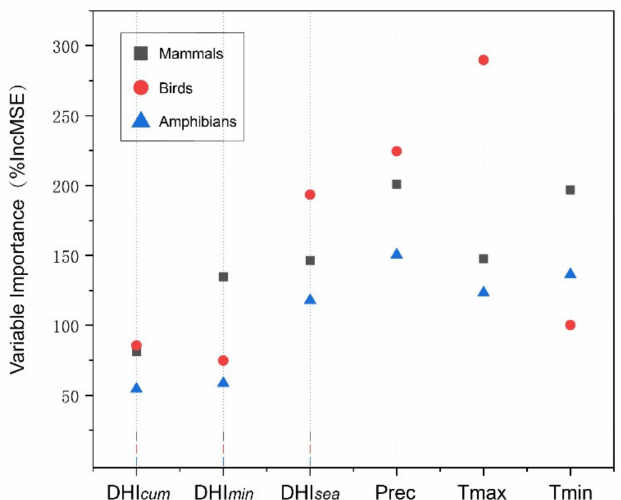
Figure 8. Variable importance plots based on RF for mammals (square), birds (circle), and amphibians (triangle). The importance of a variable is measured by the percentage increase in the mean square error of each predictor variable in the RF, with higher values implying a greater